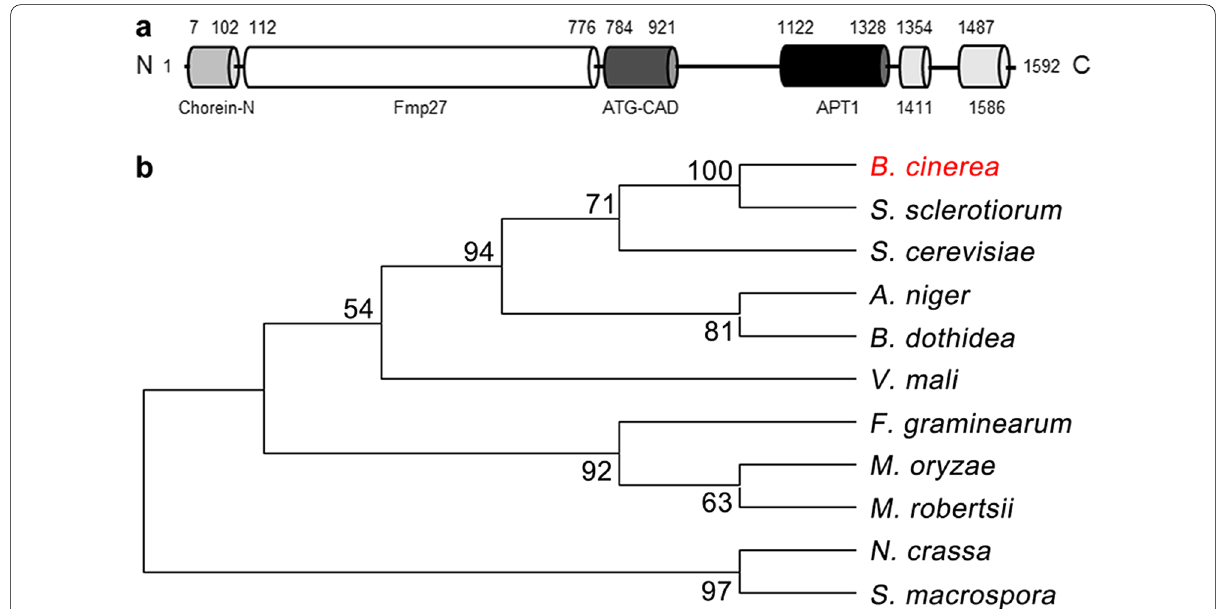
Fig. 1 Phylogenetic analysis of BcAtg2 and its orthologs from different fungal species. a Schematic representation of BcAtg2. The functional domains were predicted by SMART program (http:// smart. embl- heide lberg. de). b The phylogenetic tree of fungal Atg2 orthologs was constructed by neighbor-joining method using MEGA7 software. A. niger , Aspergillus niger ; B. dothidea , Botryosphaeria dothidea ; F. graminearum , Fusarium graminearum ; M. oryzae , Magnaporthe oryzae ; M. robertsii , Metarhizium robertsii ; N. crassa , Neurospora crassa ; S. cerevisiae , Saccharomyces cerevisiae ; S. sclerotiorum , Sclerotinia sclerotiorum ; S. macrospora , Sordaria macrospora ; V. mali , Valsa